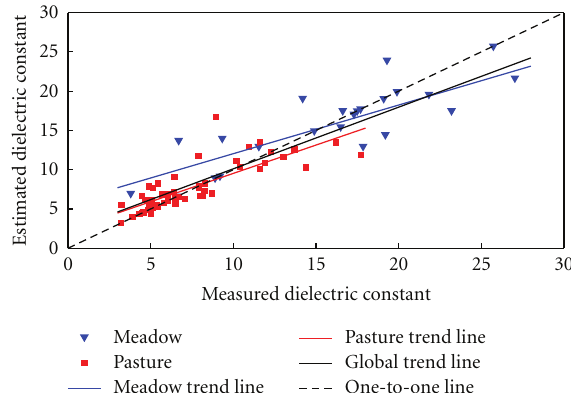
Figure 7: Scatter plot of estimated versus measured dielectric constant values obtained with the proposed algorithm with the best input features